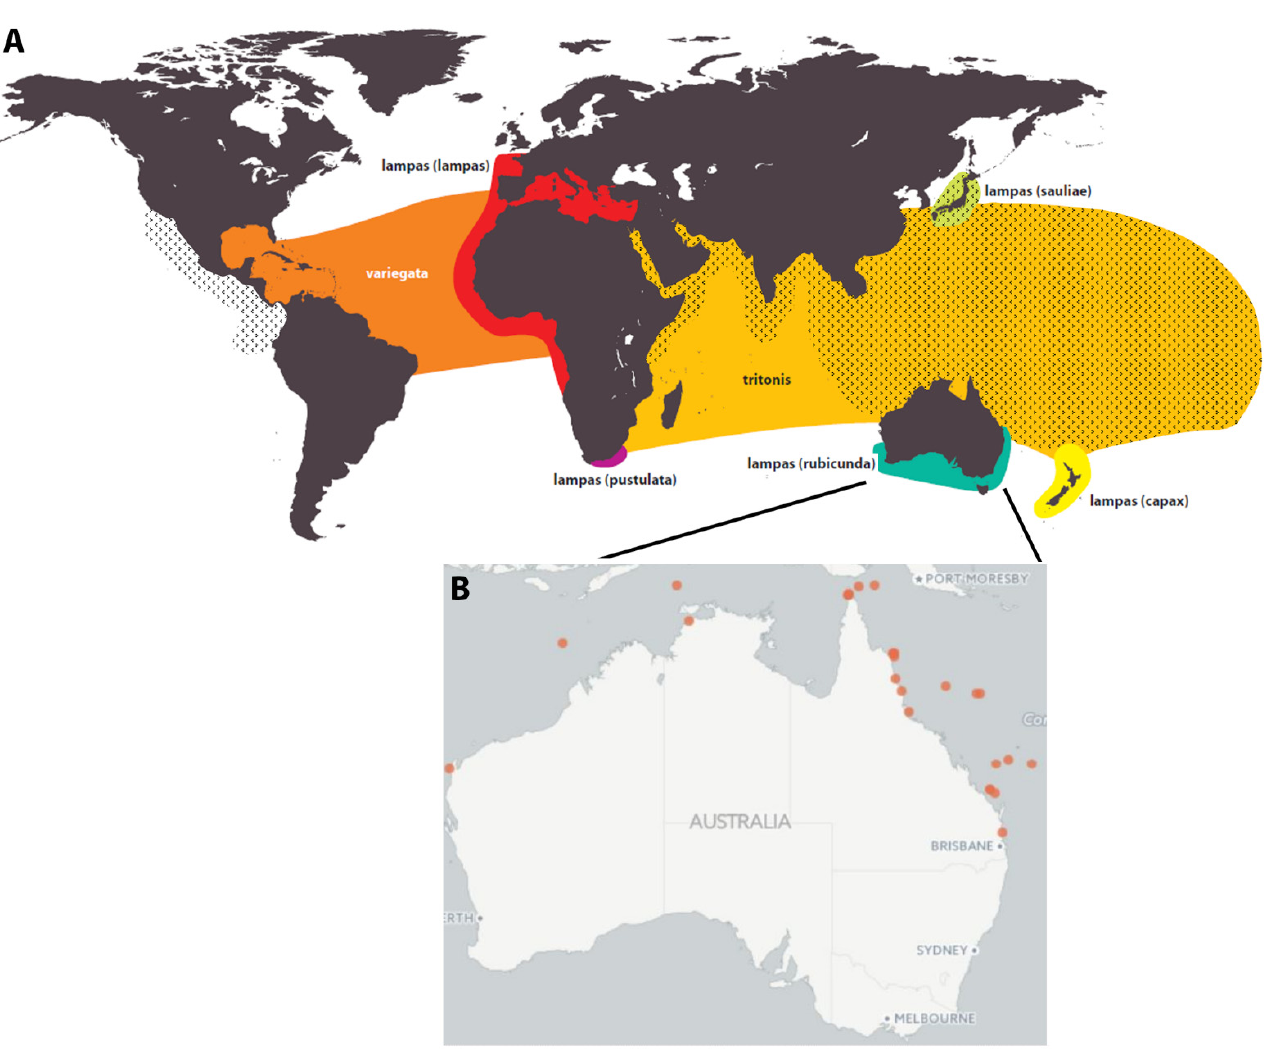
Figure 1. Distribution and range of ( A ) the Charonia genus, coloured by species, and Acanthaster cf. solaris [10], shown by hashed overlay, and ( B ) locations of reported sightings and collections of Charonia tritonis in Australia, shown by orange dots. Adapted from [56–58].